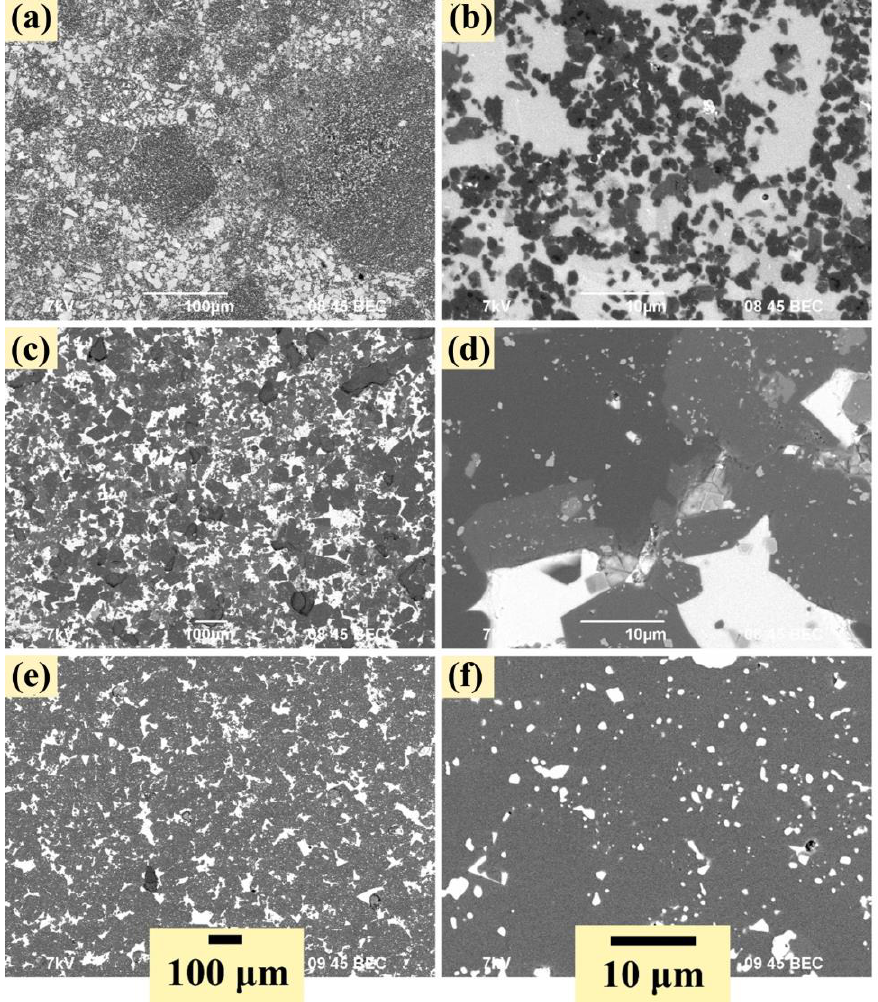
Figure 3. SEM images (BEC) of the spark plasma sintered specimens: ( a , b ) — 70Si-BAM, ( c , d ) — 50Si-BAM, ( e , f ) — 30Si-BAM.